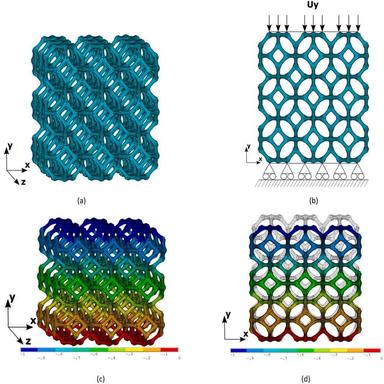
(a) 3 × 3 × 3 foam domain of a circular cross-section with discrete variation along the ligaments model; (b) boundary conditions: imposed displacement on top face and simply supported lower face. Contour of y-displacement: (c) prospective and (d) front view with undeformed model.